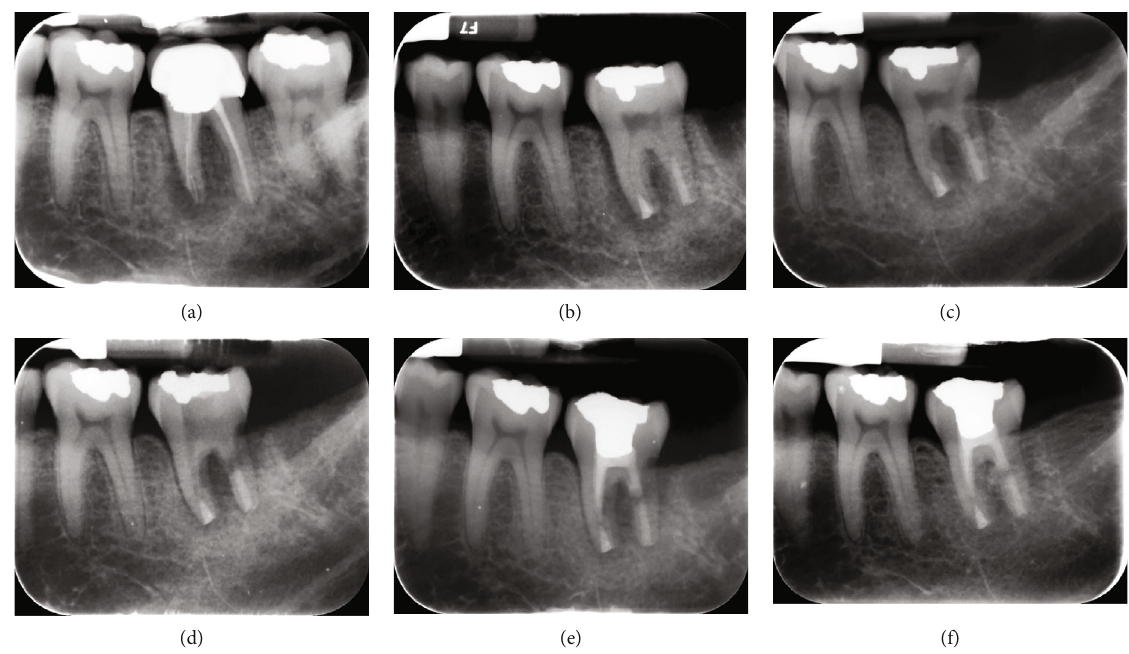
Figure 1: Mandibular left second molar with large periapical radiolucency: (a) mandibular left second molar with inappropriate previous root canal therapy, intracanal broken instruments, large periapical radiolucency, and furcation involvement; (b) former mandibular second molar was diagnosed hopeless and thus was removed whereas the mandibular left third molar was soundly extracted, and root-